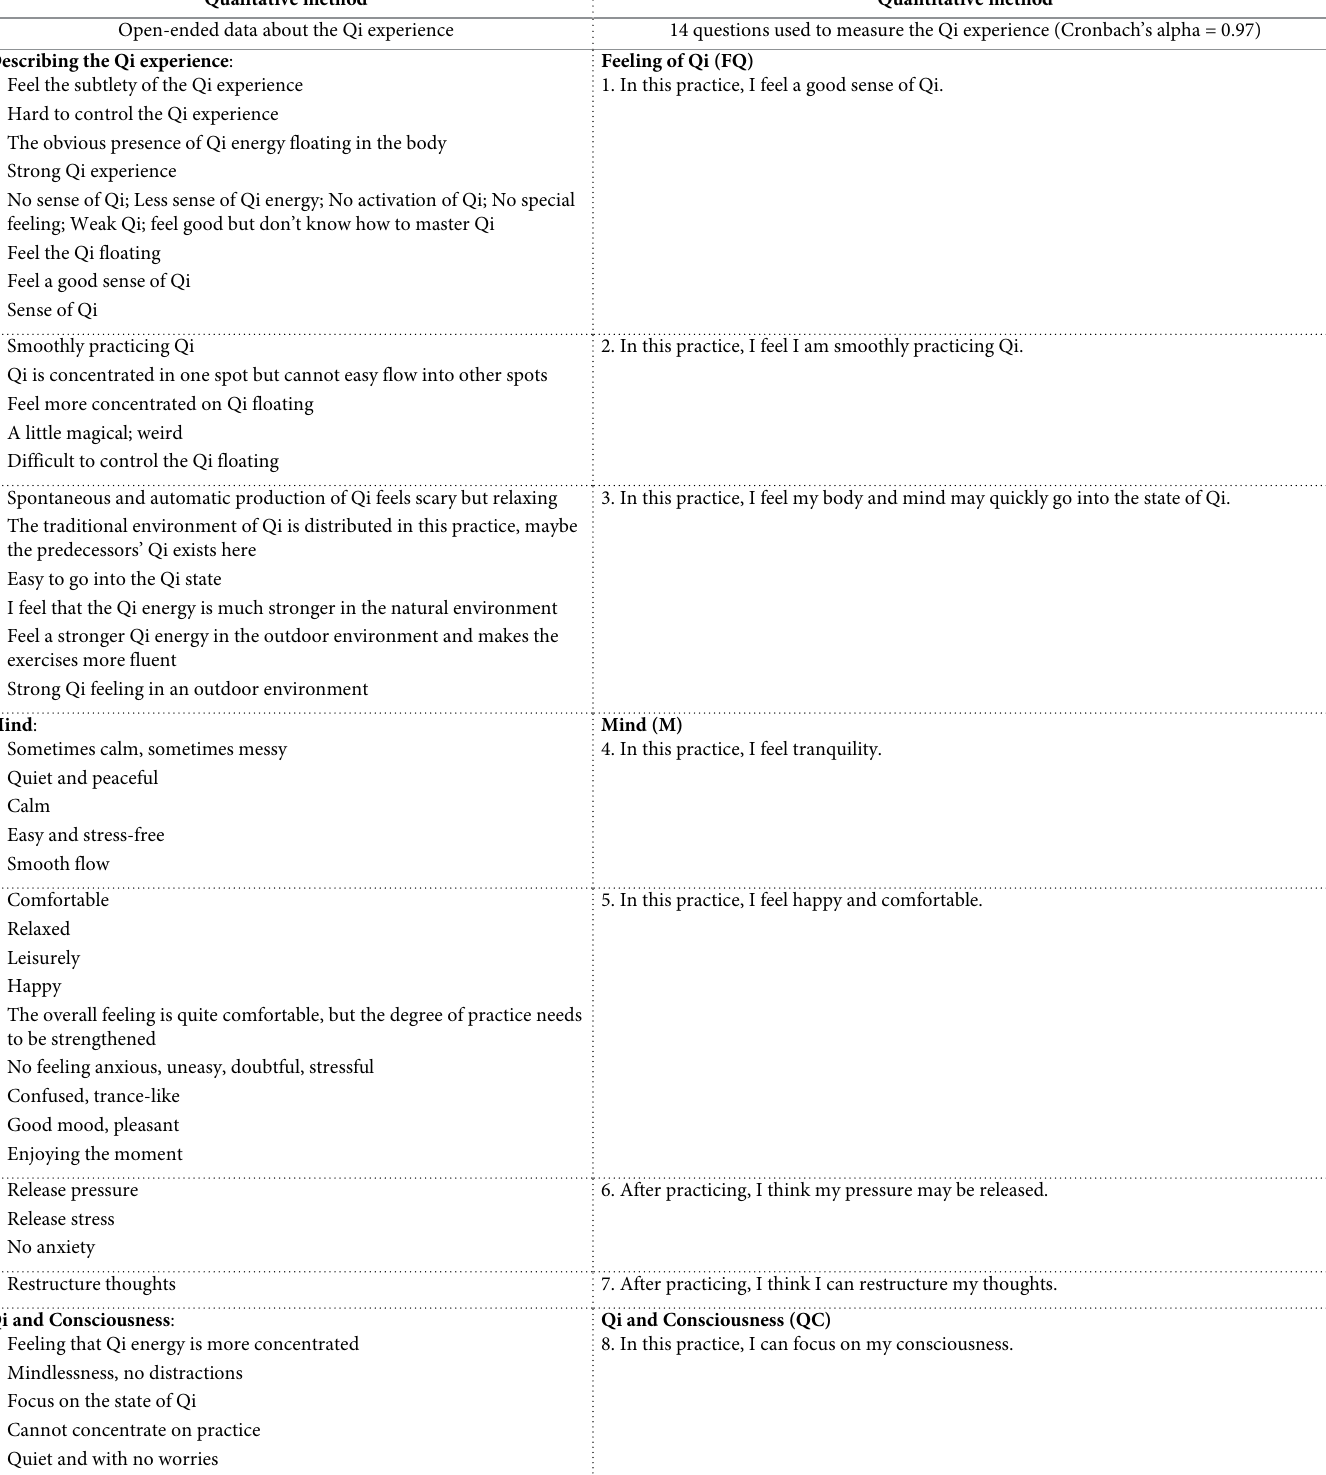
Table 2. A Fourteen questions used to measure the Qi experience based on the open-ended questionnaire